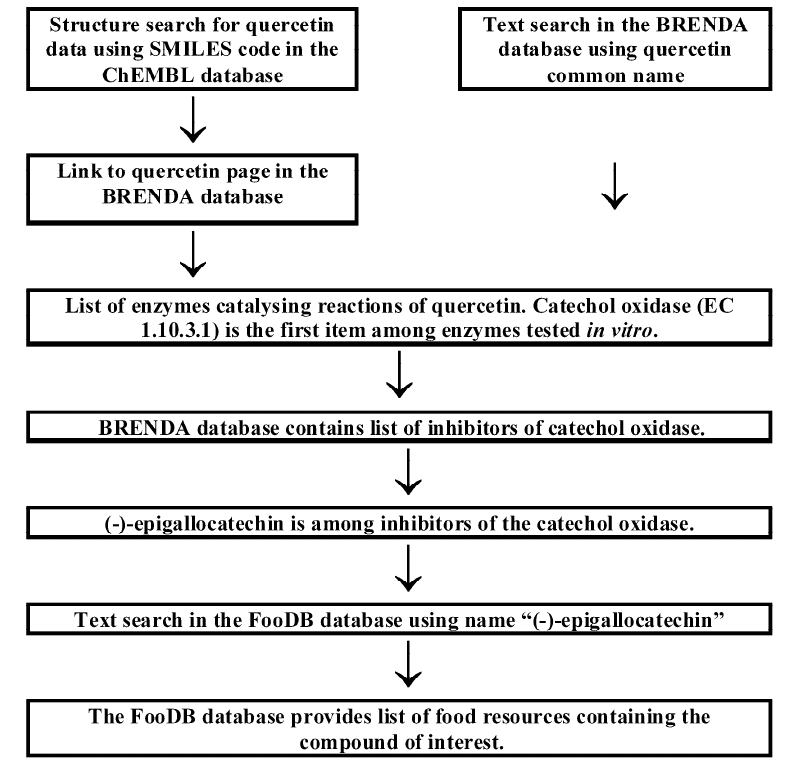
Figure 2. Possible search scheme aimed at finding inhibitors of enzymes catalysing reactions of quercetin.